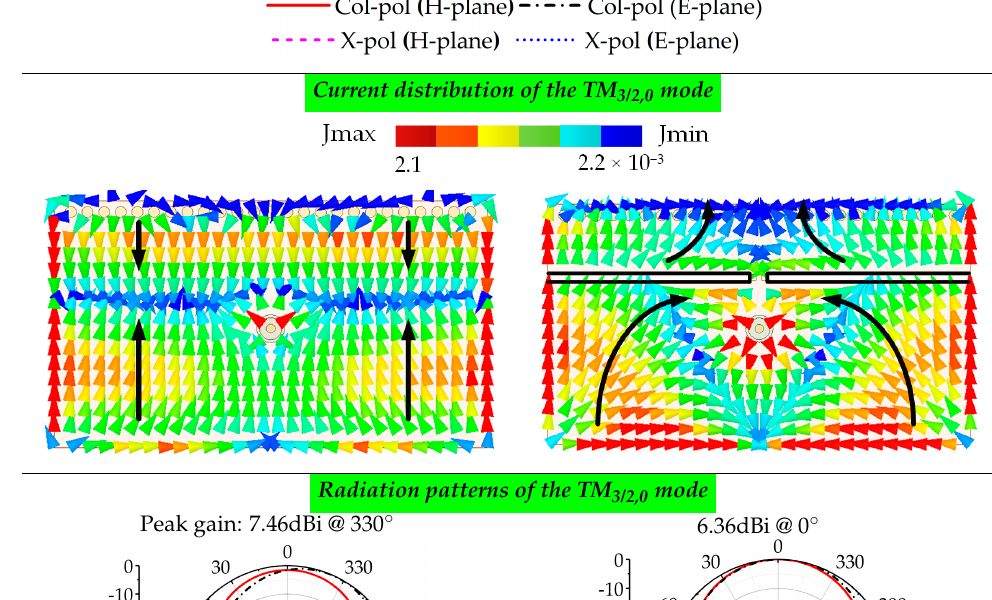
Figure 3. |S 11 |s of the three reference antennas.